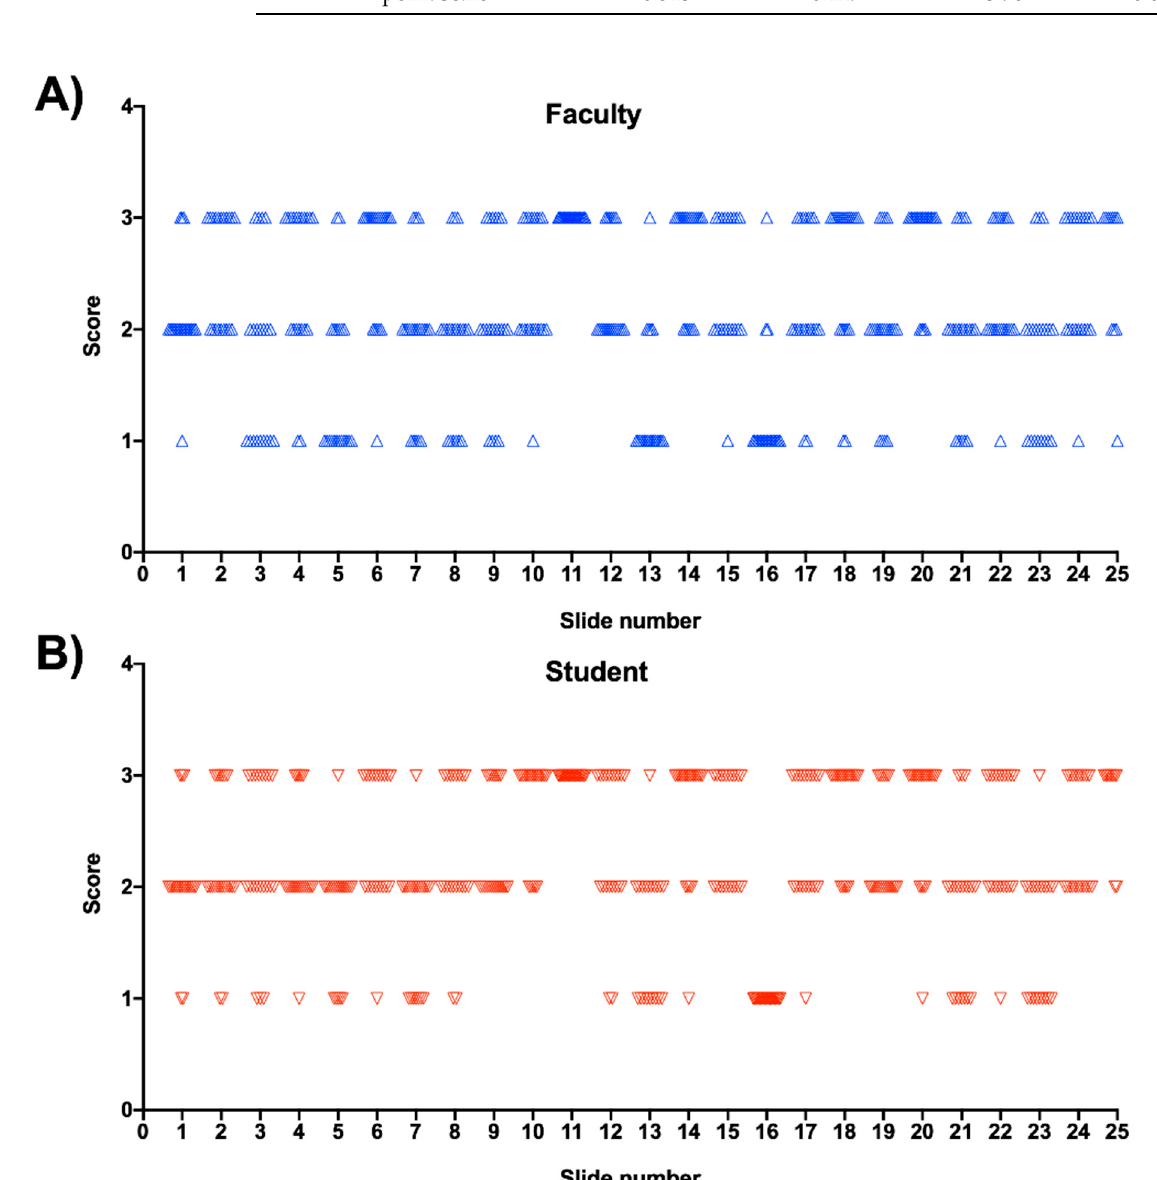
Figure 1. Scatter plot data for 3-point scale, ( A )—faculty, ( B )—students.